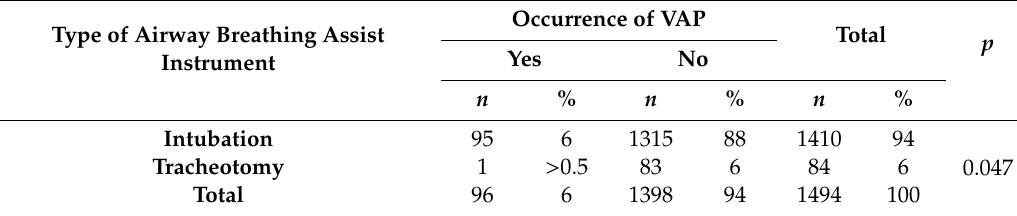
Table 4. Occurrence of VAP vs. the type of airway breathing assist apparatus. Type of Airway Breathing